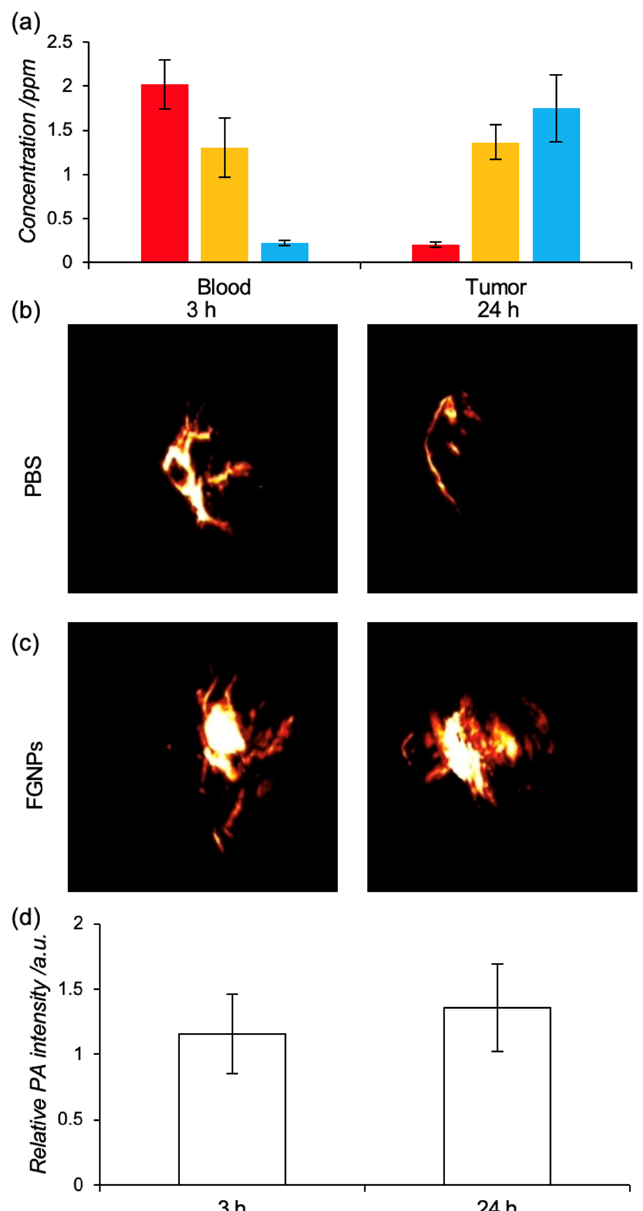
Figure 4. Tumor visualization using FGNPs by photoacoustic imaging. ( a ) Tumor accumulation and blood circulation of FGNPs in tumor xenograft mice (red, 3 h; yellow, 6 h; blue, 24 h). Data represent mean ± SD ( n = 3). FGNPs were administrated to tumor xenograft mice via intravenous injection. The accumulation of gold was quantified with ICP-AES. ( b , c ) Representative photoacoustic images of tumor tissues at 3 and 24 h after injection of PBS ( b ) and FGNPs ( c ) (FGNPs, 300 ppm). ( d ) Photoacoustic signals in tumor tissues. Data represent mean ± SD ( n =